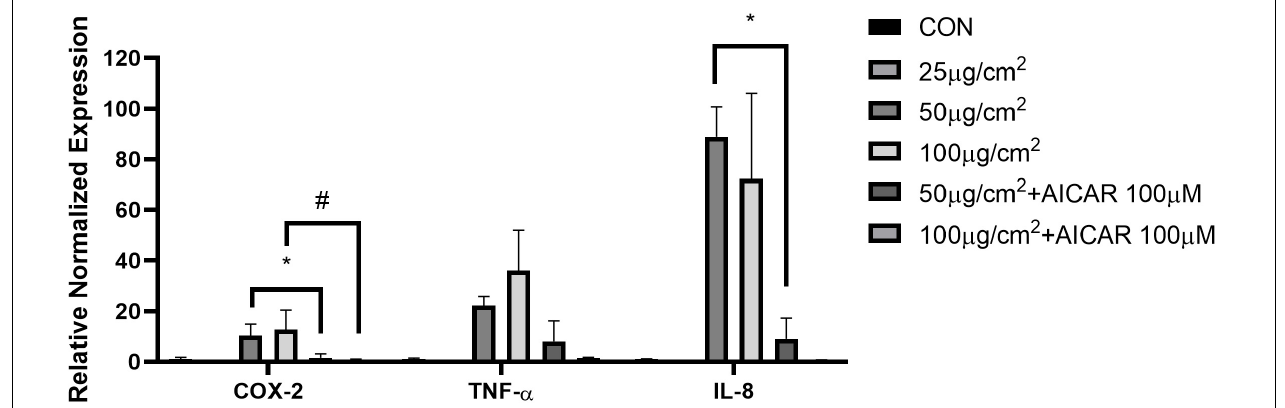
FIGURE 5 | AICAR reduced the expression of PM-triggered inflammatory factors in A549 cells. mRNA expression of pro-inflammatory factors (COX-2, TNF- α , and IL-8) with and without AICAR treatment during PM exposure for 48 h in A549 cells. Values are mean ± SEM. * P < 0.05 vs. 50 µ g/cm 2 , # P < 0.05 vs. 100 µ g/cm 2 .